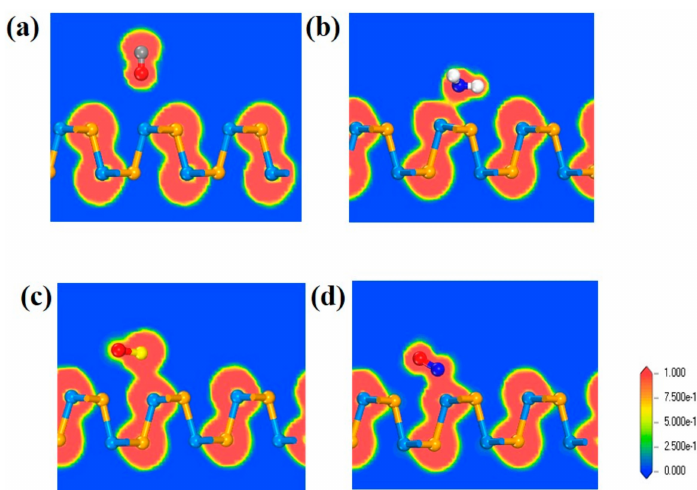
Figure 3. The distribution of electron localization maps of ( a ) CO, ( b ) NH 3 , ( c ) SO 2 , and ( d ) NO 2 configurations. The reference column for the electron localization function (ELF) value from 0 to 1 is located on the right side of the figure, representing blue and red, respectively. The slice of the ELF is parallel to the (100) crystal plane.